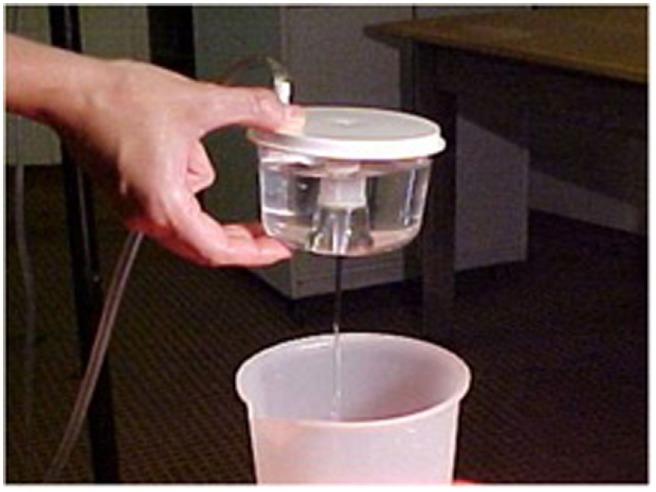
Uterine flushing media recovered through a VCI® High Volume filter for embryos into a graduated container.